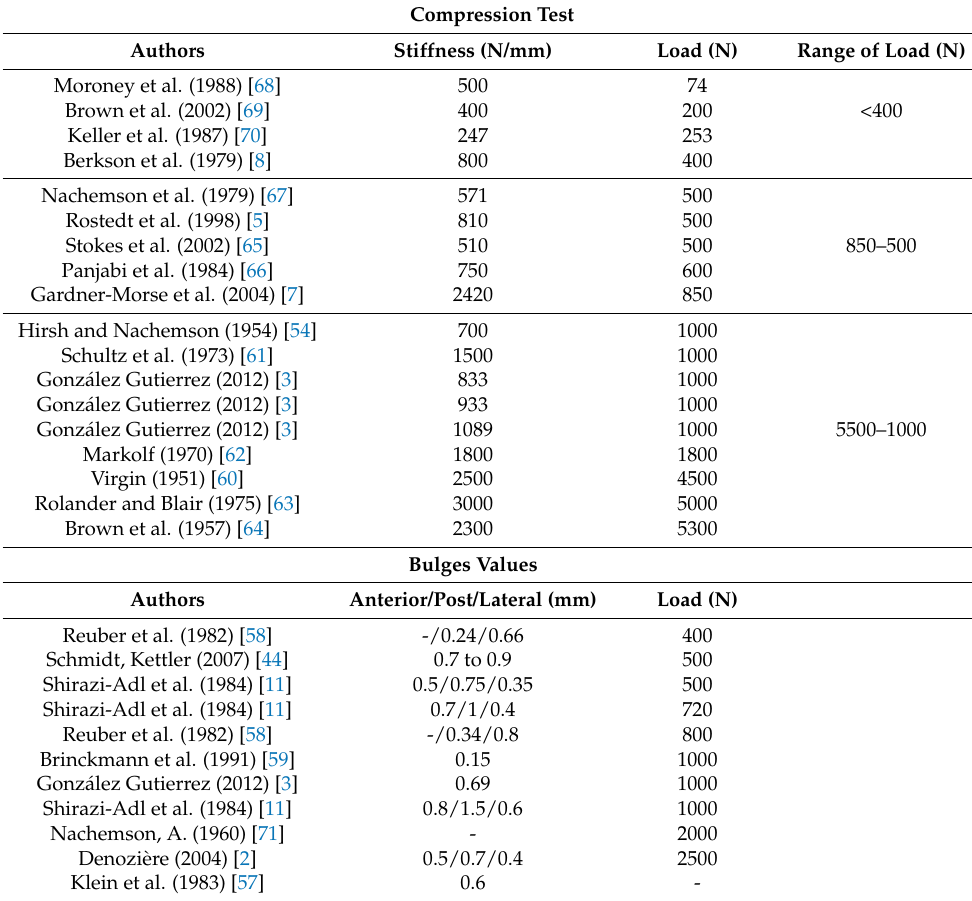
Table 2. Summary of stiffness, bulges, and compression loads from various